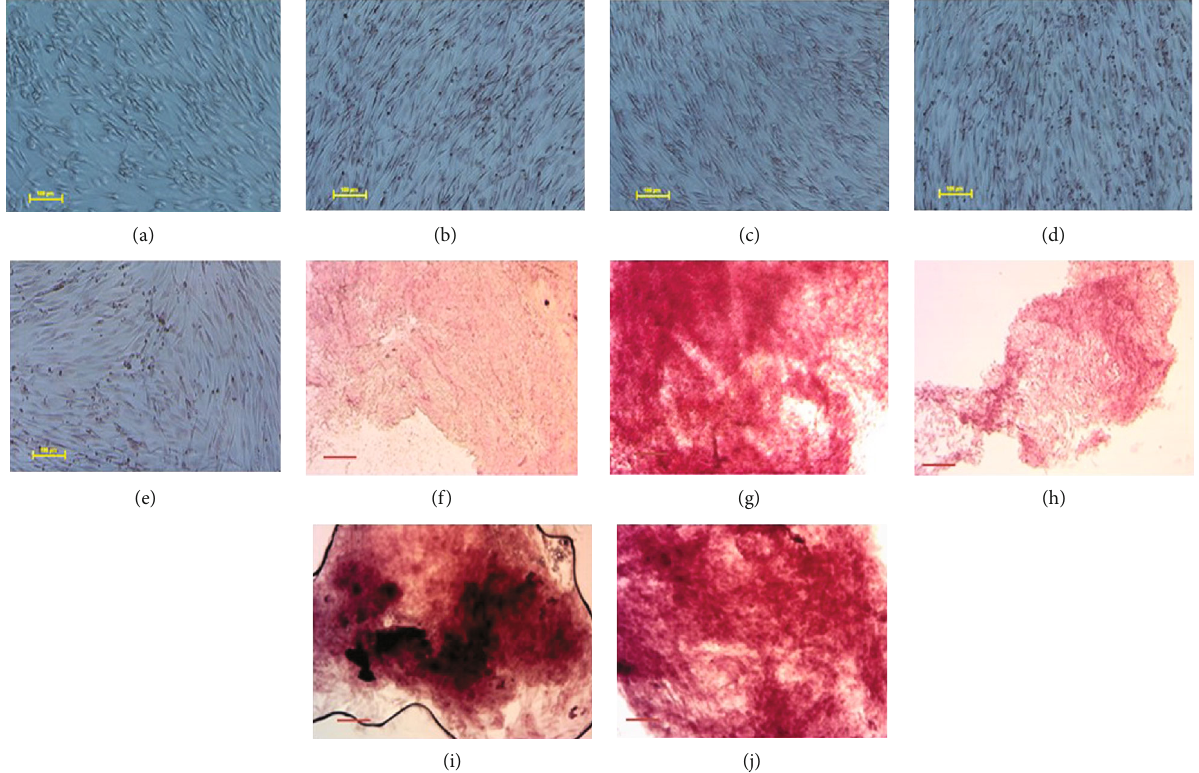
Figure 3: Osteogenic di ff erentiation of MSCs cultured under hypoxia and normoxia. Alizarin Red S staining for cells di ff erentiated for 19 days imaged in (a – e) culture wells and (f – j) on coverslips. (a) Negative control, (b) passage 5 hypoxia (P5H), (c) passage 9 hypoxia (P9H), (d) passage 5 normoxia (P5N), and (e) passage 9 normoxia (P9H). Scale bar 100 μ